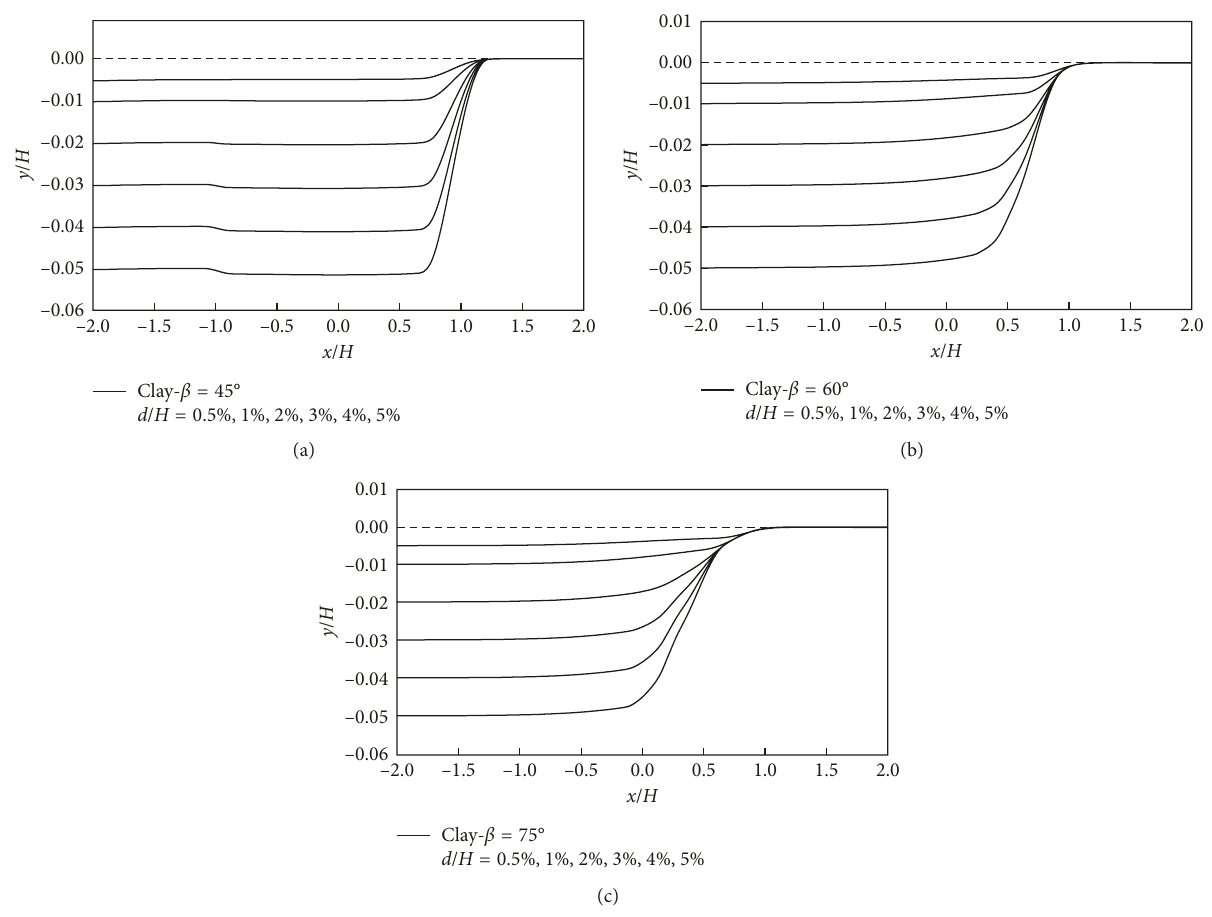
Figure 9: The ground displacement curves with different dip angles for the normal fault in clay: (a) 45 ° , (b) 60 ° , and (c) 75 °